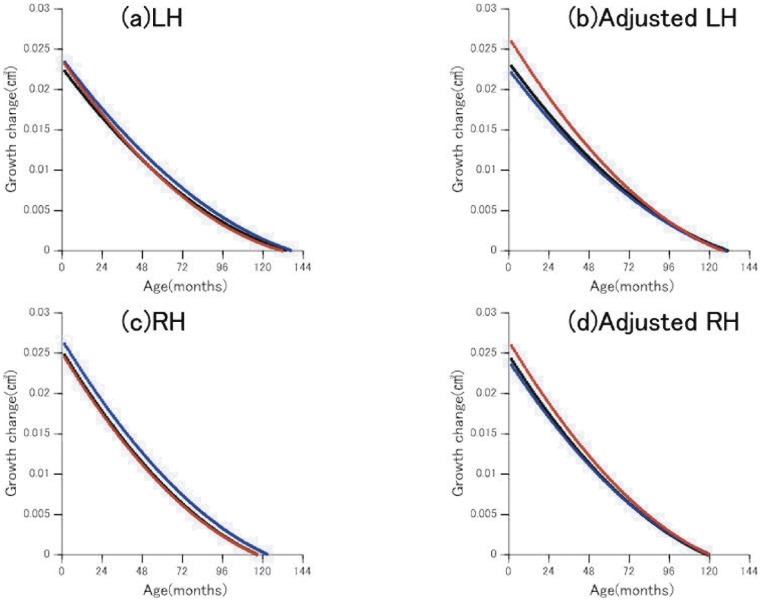
Rate of growth change in hippocampal volumes.(a); LH: left hippocampus, (b);left hippocampus adjusted by ICV, (c); RH: right hippocampus, (d);right hippocampus adjusted by ICV. The rates of monthly volume changes in the right and left hippocampus. Positive values indicate increasing volume. The point of intersection on the x-axis represents the age of local maximal volume. Black line: whole group, blue line: males, red line: females.